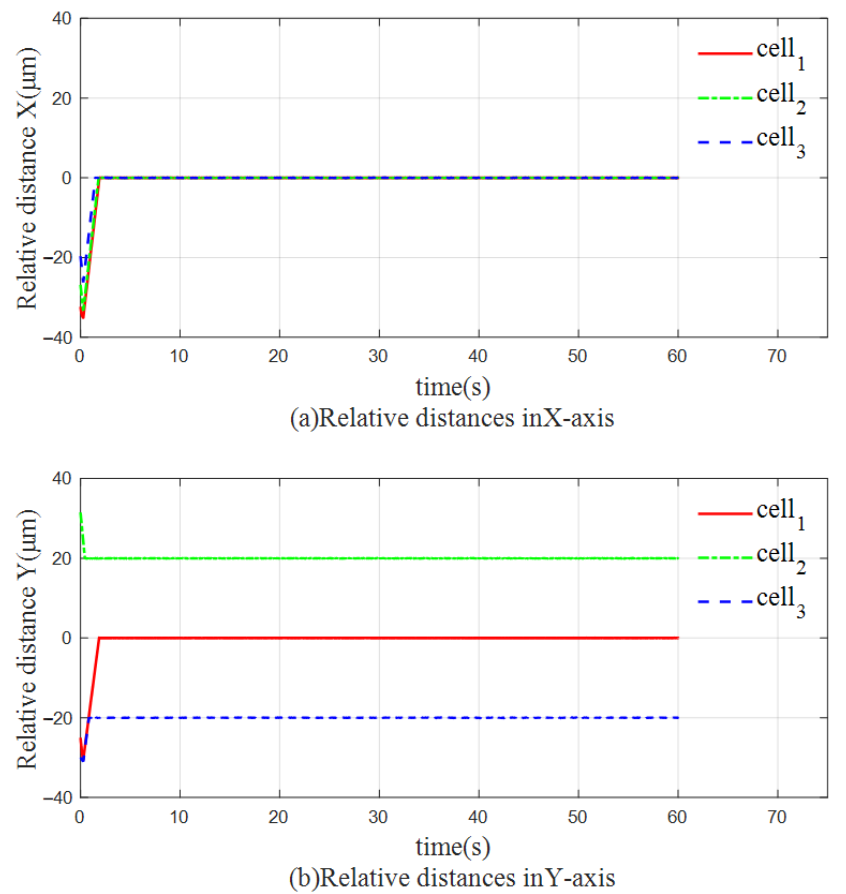
Figure 11. The relative distance between each yeast: ( a ) The relative distance of the three cells in the X-axis direction. ( b ) The relative distance of the three cells in the Y-axis direction.